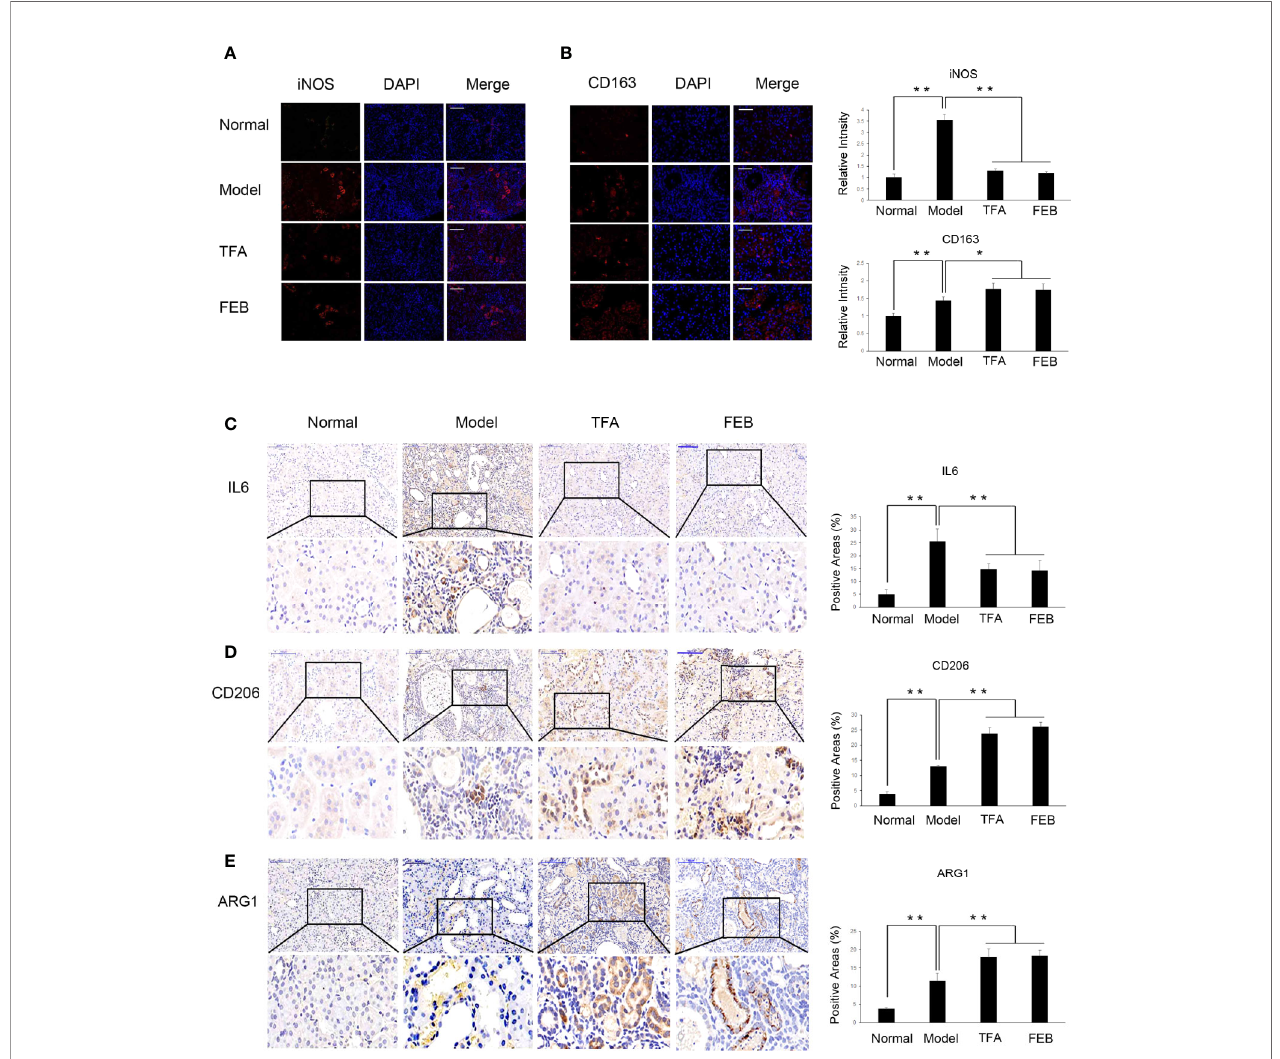
FIGURE 5 | Effects of TFA and FEB on macrophage polarization in vivo . (A, B) Immuno fl uorescence staining of iNOS and CD163 in the kidneys of the Normal, Model, TFA, and FEB rats. Scale bar: iNOS, 100 m m; CD163, 50 m m. (C – E) Immunohistochemical staining of IL6, CD206, and ARG1 in the kidneys of the Normal, Model, TFA, and FEB rats. Scale bar: 100 m m. * P < 0.05, ** P < 0.01. TFA, total fl avones of Abelmoschus manihot ; FEB, febuxostat; iNOS, inducible nitric oxide synthase; IL6, interleukin 6; ARG1, arginase